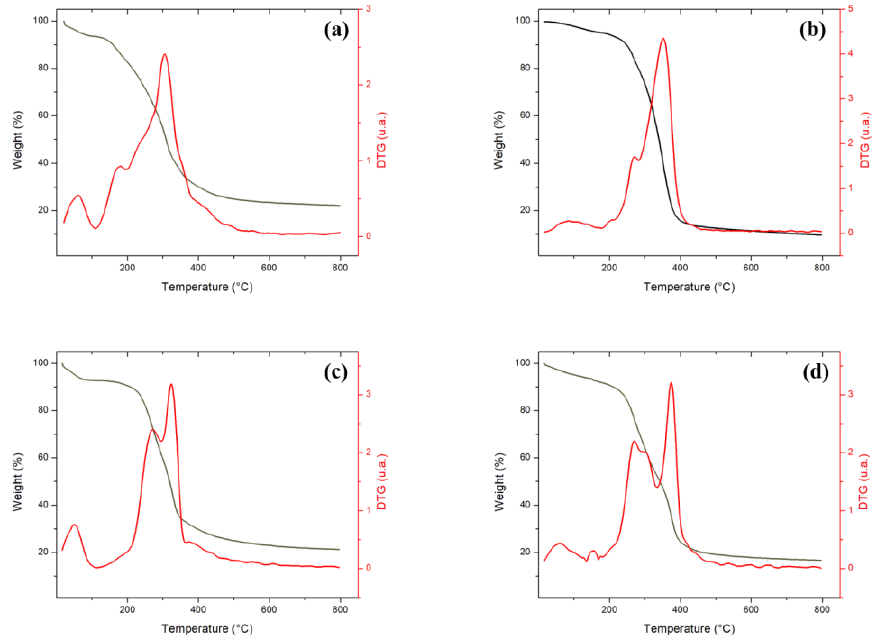
Figure 1. Thermogravimetric and derived curves to precursors ( a ) FIB, ( b ) ALM, ( c ) END, and ( d ) DOA.